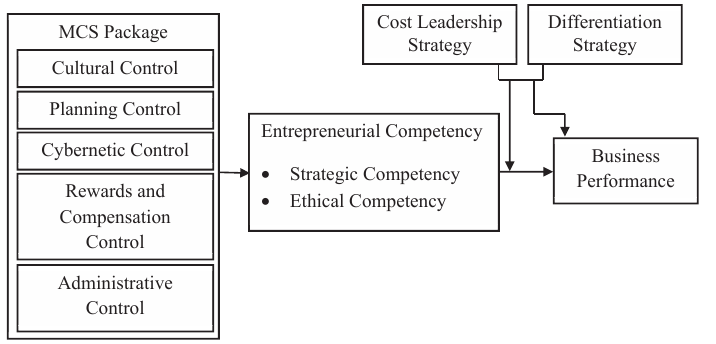
Figure 1. Theoretical